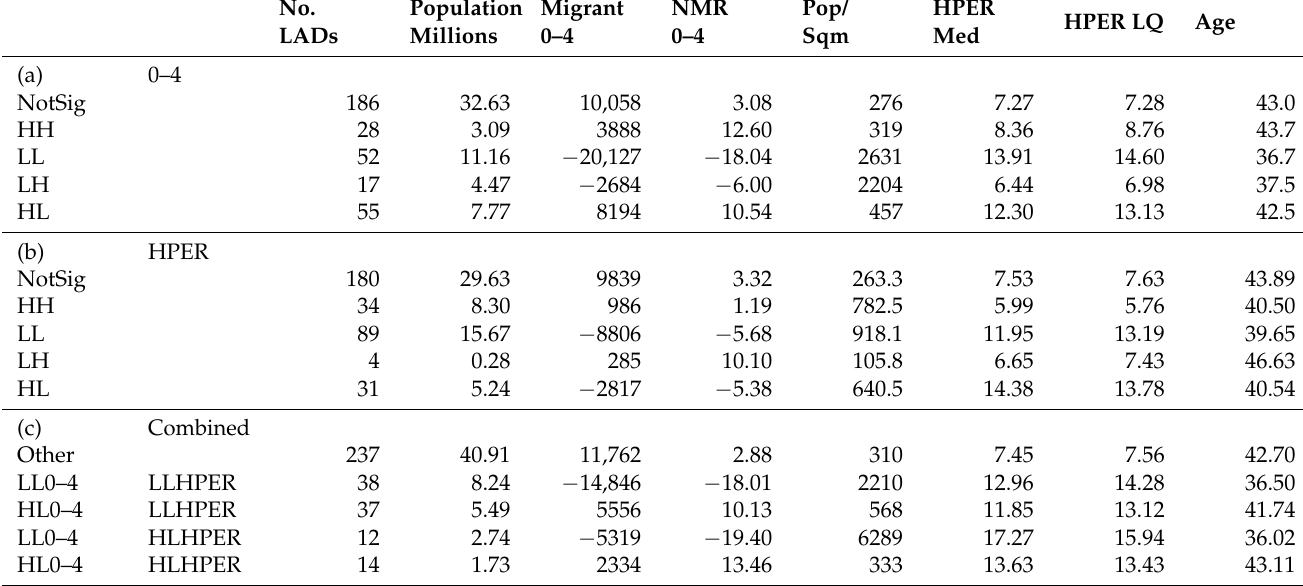
Table 2. LISA combinations migration and house price–earnings ratio. This table reports house price earnings ratios (HPER) and net migration rates (NMR). It also reports the number of districts (LAD) in the cluster, the total population, its average age, and the number of infant